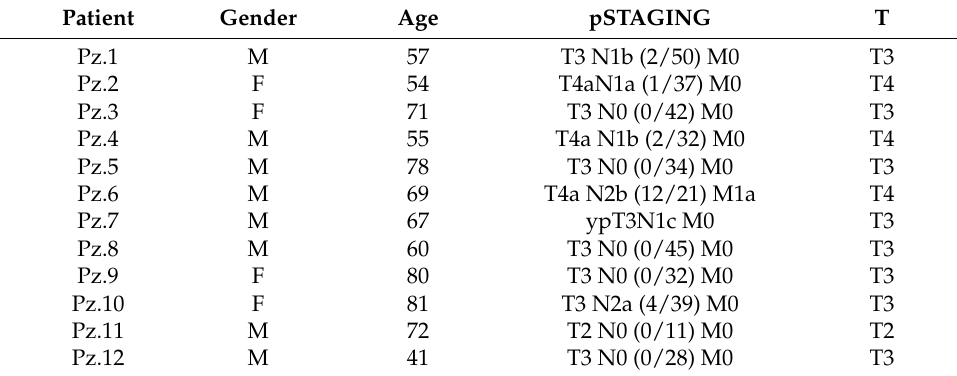
Table 2. Baseline characteristics of colon cancer